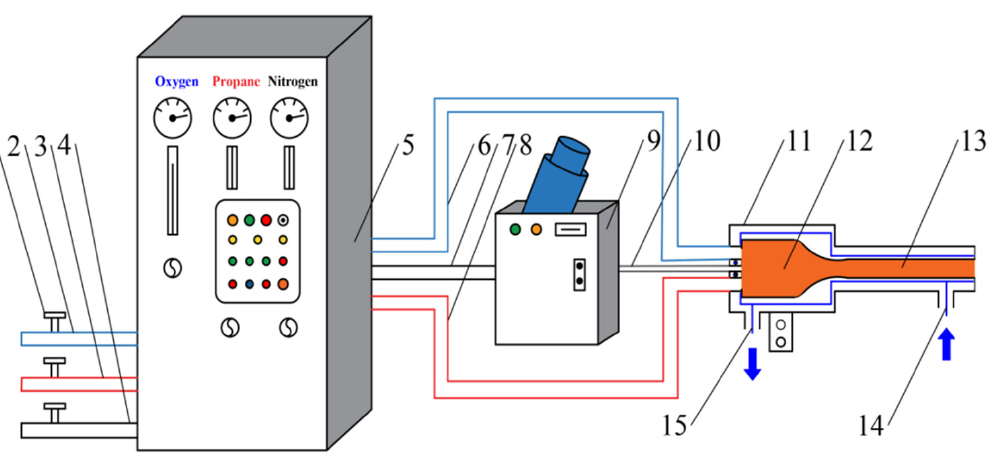
Figure 3. Schematic diagram of HVOF and WS spray system: (1) valve, (2,6) oxygen pipe, (3,8) propane pipe, (4,7) nitrogen pipe, (5) console cabinet, (9) powder feeder, (10) powder feeding pipe, (11) spray gun, (12) flame chamber, (13) spraying tube, (14) cold water inlet, and (15) cold water outlet.